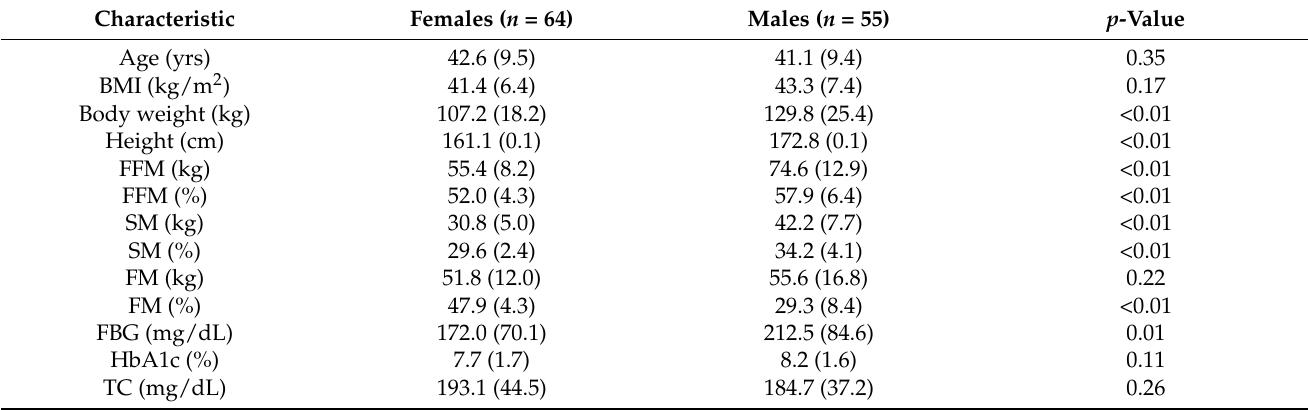
Table 1. Baseline demographic and disease